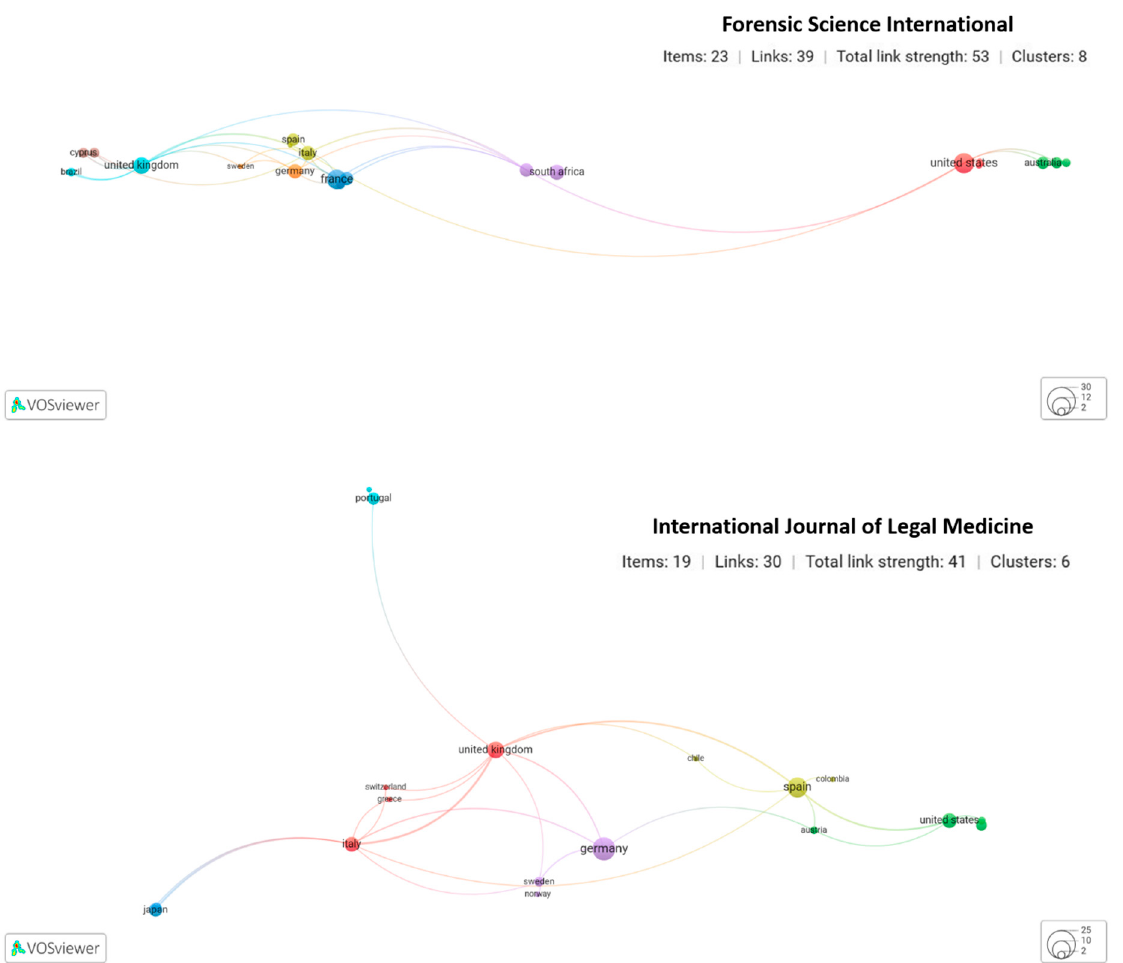
Figure 9. Network visualization of co-authorship by institutional countries for publications of the Forensic Science International and the International Journal of Legal Medicine. The interactable maps are accessible at: Forensic Science International https://app.vosviewer.com/?json=https://drive.google.com/uc?id=1dy7RVu39t4y7UyjpAvtIhnVQsKLIAp1_; International Journal of Legal Medicine https://app.vosviewer.com/?json=https://drive.google.com/uc?id=1glHeo3fqa56IE- GXq9aq586JRmgmjtojU (Accessed on 16 January 2023).